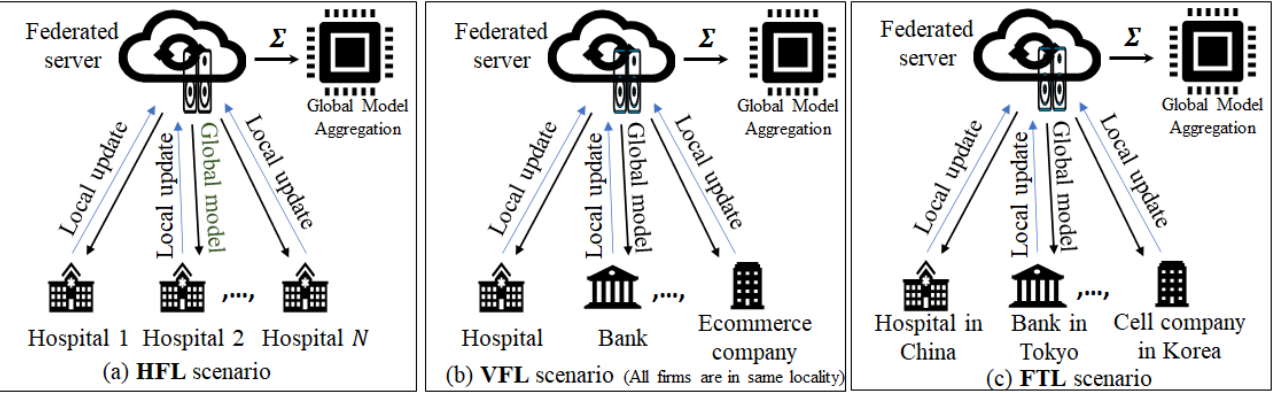
Figure 2. Overview of the classification in the FL